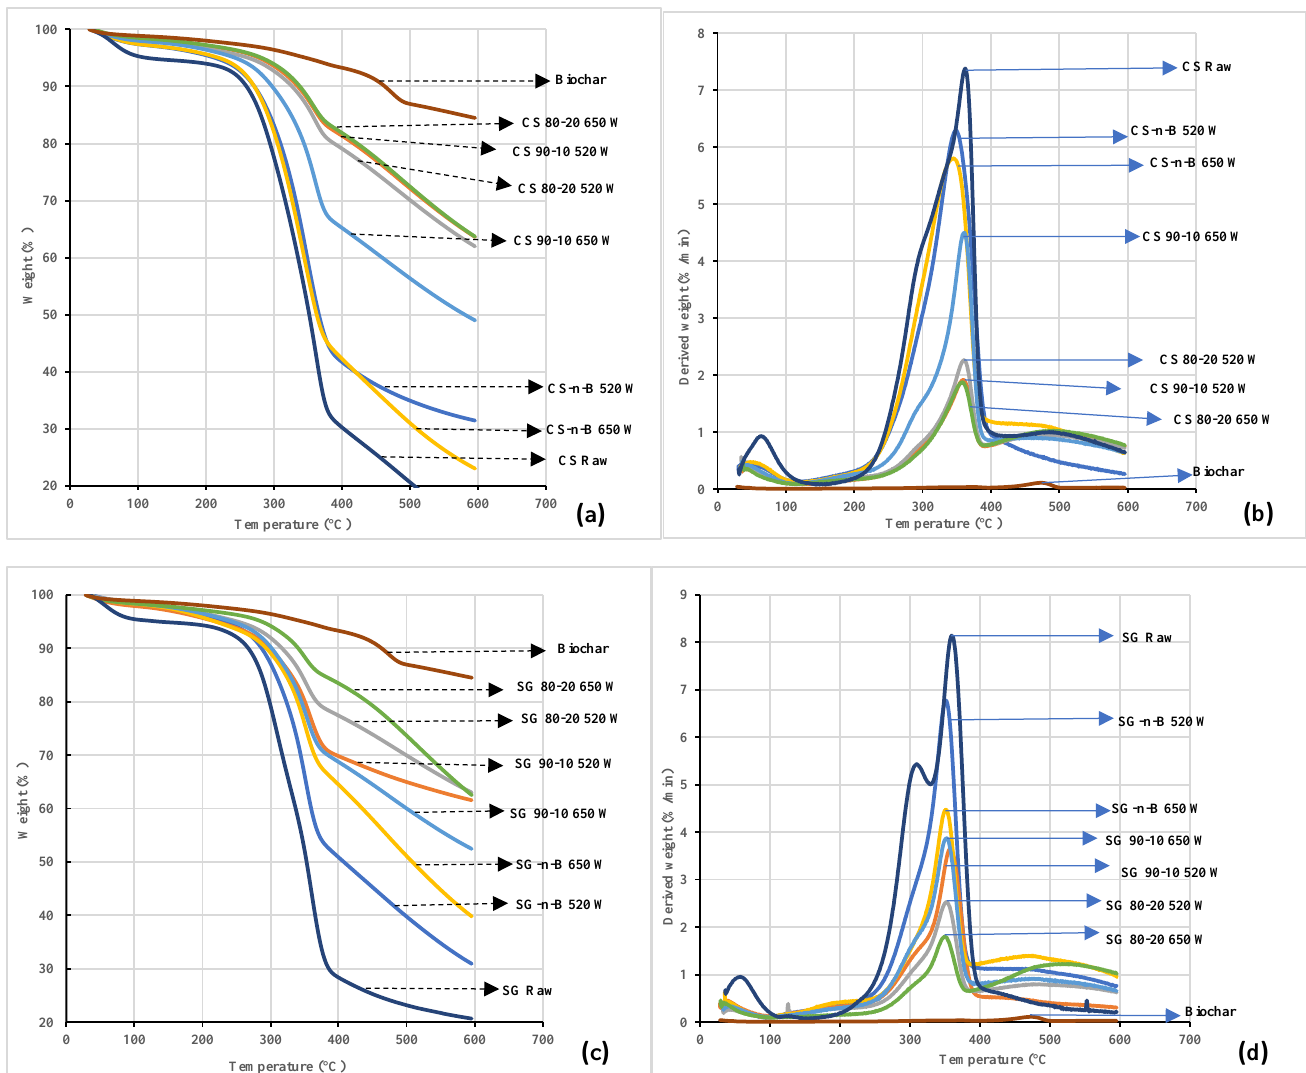
Figure 9. Thermogravimetric curves of raw and torrefied camelina straw and switchgrass with biochar-mix at 15 min residence time ( a ) TGA of CS, ( b ) DTG analyses of CS, ( c ) TGA of SG, ( d ) DTG analyses of SG. CS: camelina straw; CS-n-B: camelina straw-no-biochar; SG: Switchgrass; SG-n-B: Switchgrass-no-biochar. The first number after the biomass is % of biomass, and the second number is % of biochar.